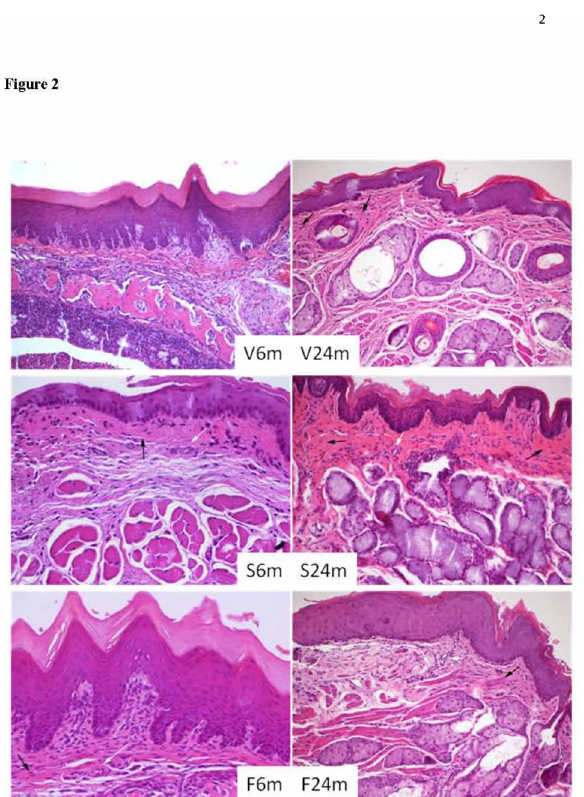
Figure 2. Histological features of gingival tissue in young (6 months old, left column) and old (24 months old, right column) rats fed on virgin olive (V), sunflower (S) or fish (F) oils. White arrows show areas with activated endothelial vessels. Black arrows show areas with fibrosis.